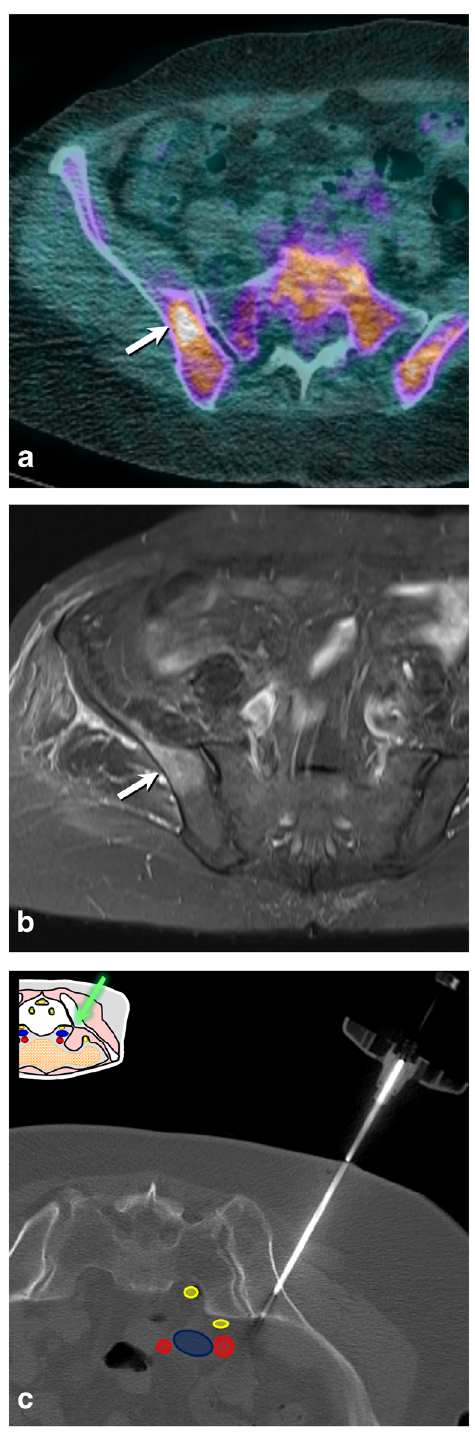
Fig. 9 A 77-year-old woman presenting with multiple foci of increased bone metabolism on PET scan and no known primary tumour ( a , arrow ) and abnormal bone marrow signal on MRI ( b , arrow ). The lesions were not visible on CT and a biopsy of the most conspicuous lesion was carefully planned using anatomical landmarks ( c ). The lesion was targeted through a direct approach and proved to be non-Hodgkin ’ s